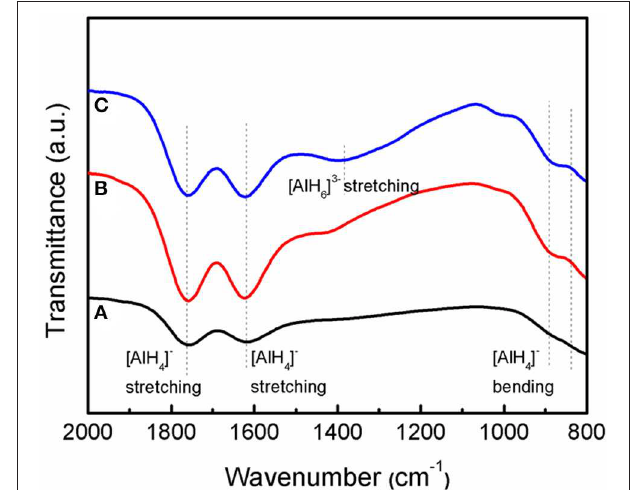
FIGURE 8 | IR spectra of the LiAlH 4 when (A) as-received, (B) as-milled, and (C) with 10 wt.% of K 2 NbF 7